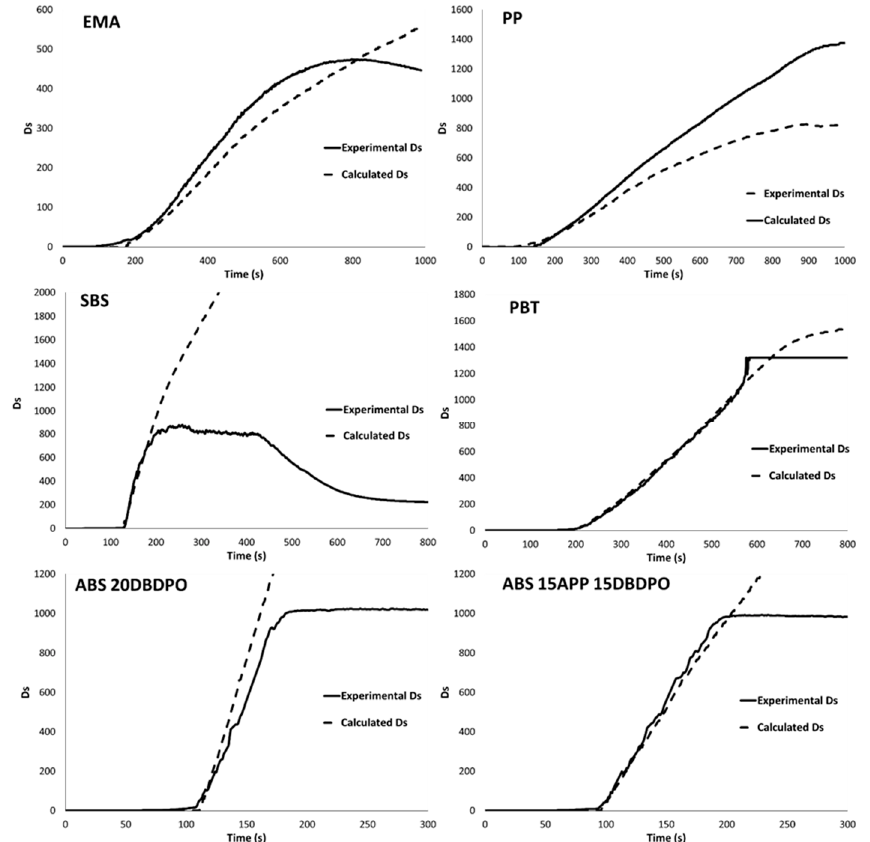
Figure 10. Experimental and calculated Ds versus time for materials tested in smoke chamber at 25 kW/m 2 .